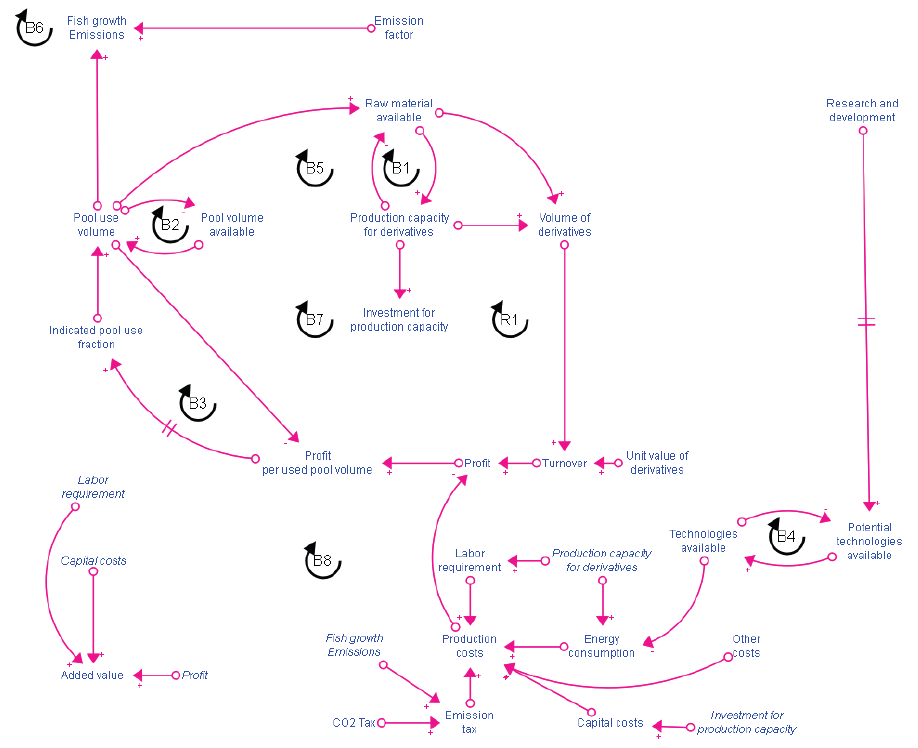
Fig. 5. Aquaculture causal loop